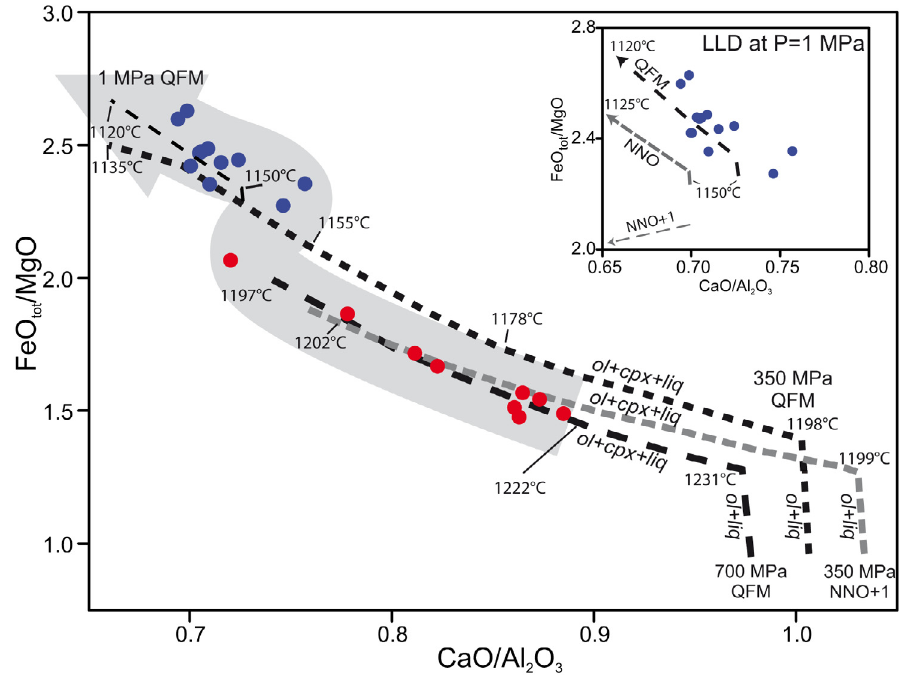
Figure 11. Comparison between compositions of bulk rocks (red solid circles), glass (blue solid circles) and liquid lines of descent (LLD) ob- tained by thermodynamic modeling of cooling (range of temperature are reported) and fractional crystallization at different pressures (700- 1 MPa) under distinct oxidation conditions (from QFM to NNO+1). Gray arrow describe possible ascent path of magma that starts to crystallize at 700 MPa (between 1300 and 1200°C under QFM) or at 350 MPa (between 1199 and 1160°C under NNO+1), moves at lower pressure and finally quench at temperatures between 1150°C down to 1120°C, close to the surface. Inset shows liquid line of descent at P = 1 MPa (water depth of 100 m) under different oxidizing conditions and glass compositions measured during the 2011-12 El Hierro